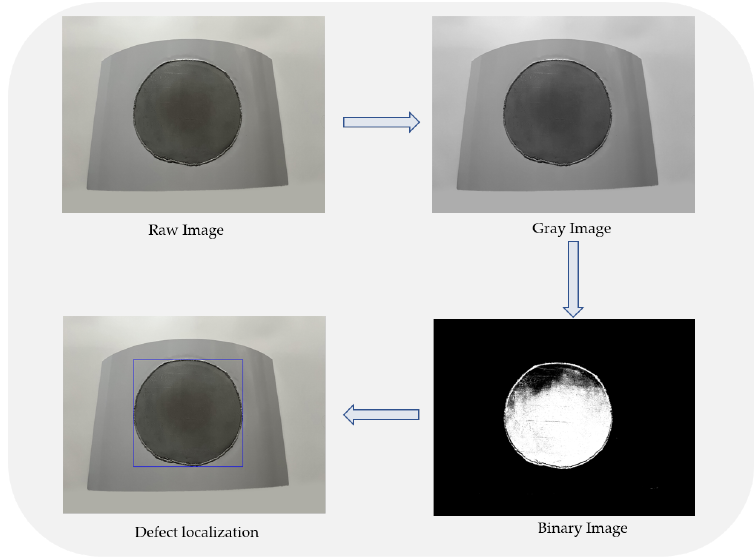
Figure 3. Flowchart of 2D defect area